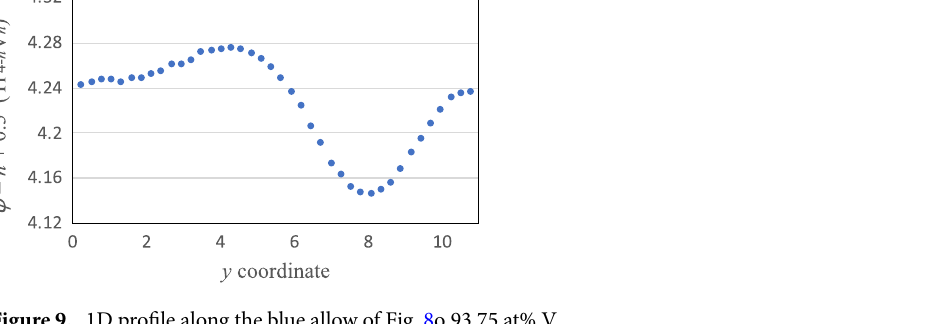
Figure 9. 1D profile along the blue allow of Fig. 8o 93.75 at%